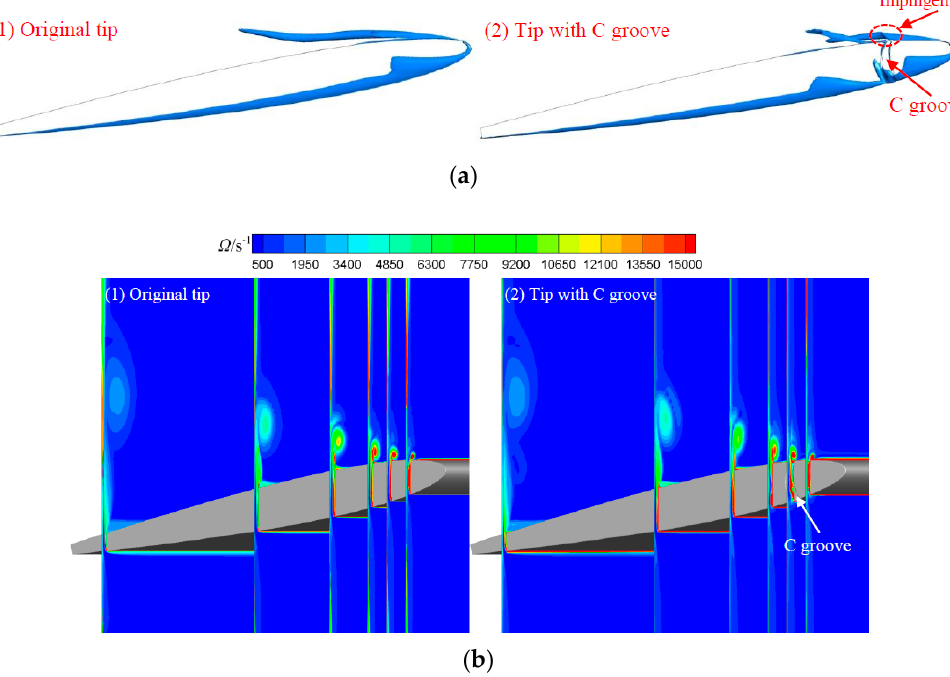
Figure 35. Suppression effect of C-groove method on TLV [82]. ( a ) Vortex defined by Q criterion ( Q = 3 × 10 7 s − 1 ); ( b ) vorticity magnitude on six streamwise planes.